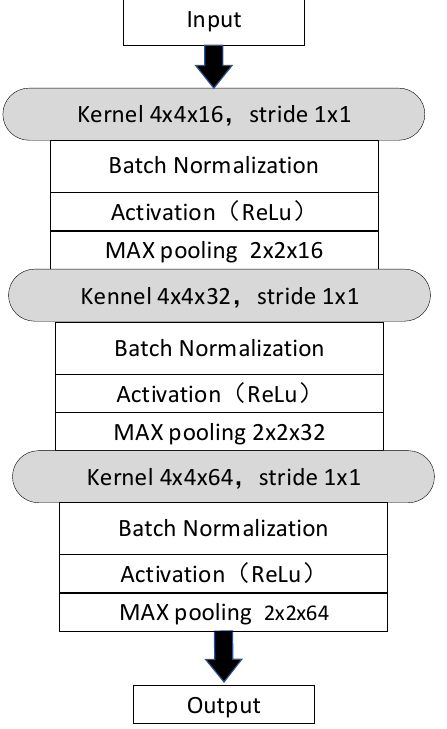
Figure 8. The architecture of